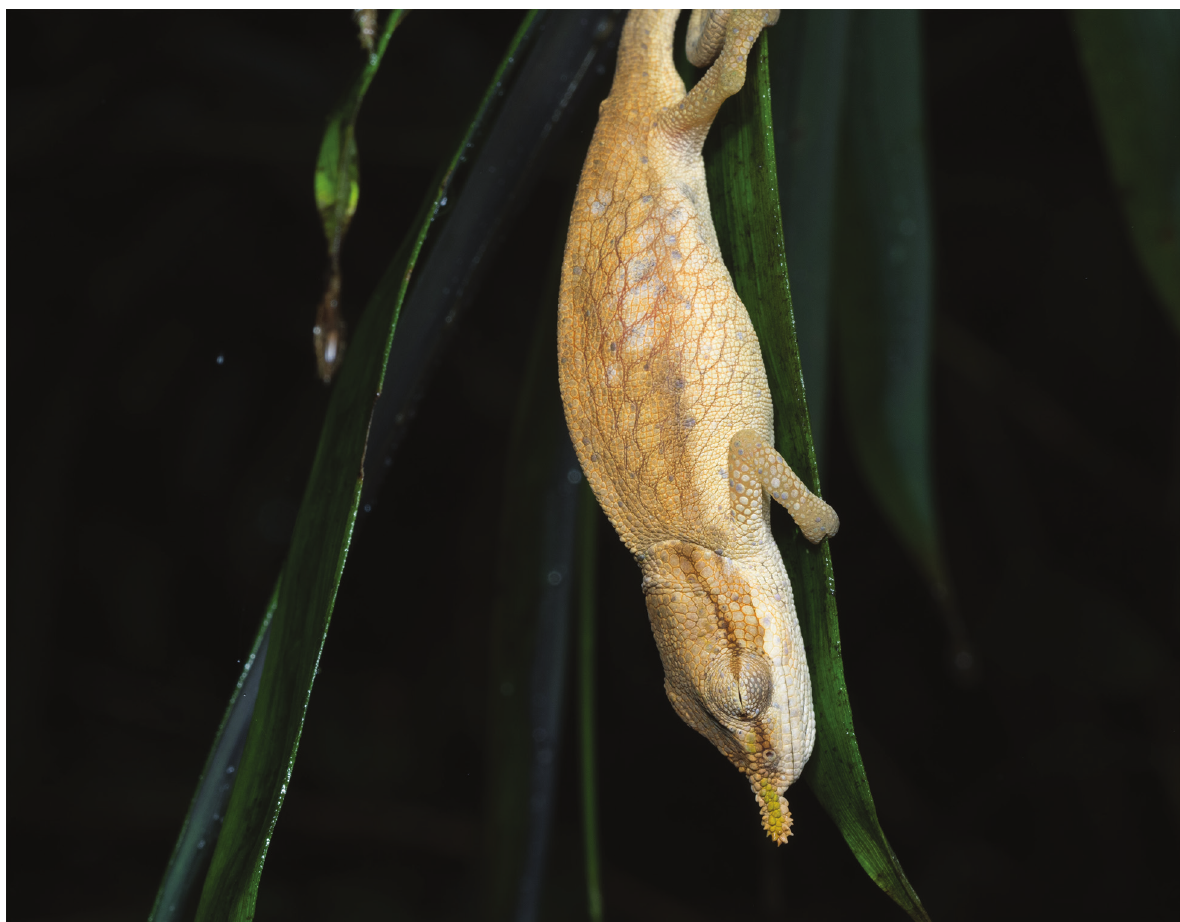
Figure 7. In-situ photograph of an uncollected (in sleeping position) female of Calumma roaloko sp. n. , from the same locality as KU